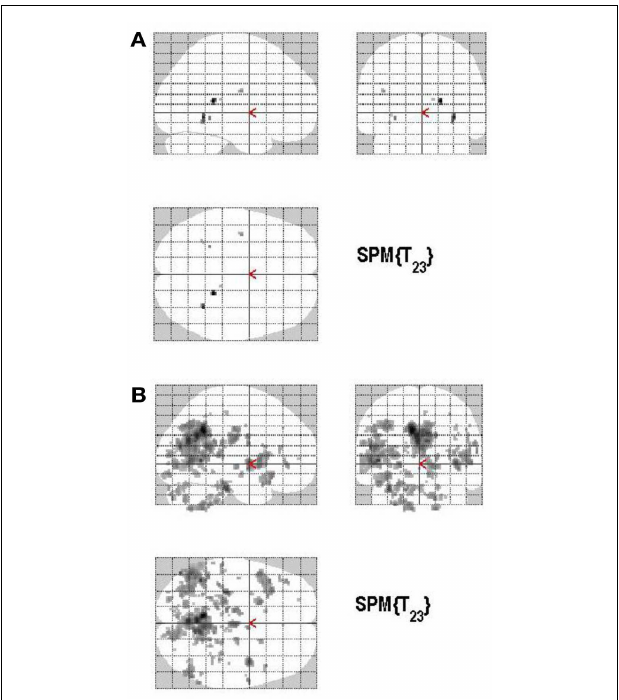
FIGURE 5 | (A) Group activations for the contrast between high versus low secureness (MONITORING). Activations are superimposed on the anatomical group mean image (see Materials and Methods), depicting statistically significant relative increases in neural activity at p < 0.001, uncorrected. See Table 2A for the exact MNI coordinates. (B) Group activations for the contrast between low versus high secureness (MONITORING). Activations are superimposed on the anatomical group mean image (see Materials and Methods), depicting statistically significant relative increases in neural activity at p < 0.001, uncorrected. See Table 2B for the exact MNI